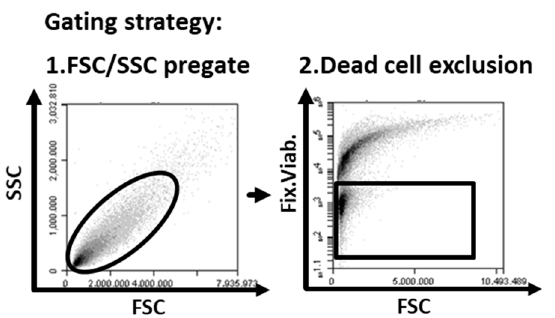
Figure A7. Gating strategy. Cells were pregated via forward- and side scatter (FSC / SSC) following a dead cell exclusion via fixable viability dye.